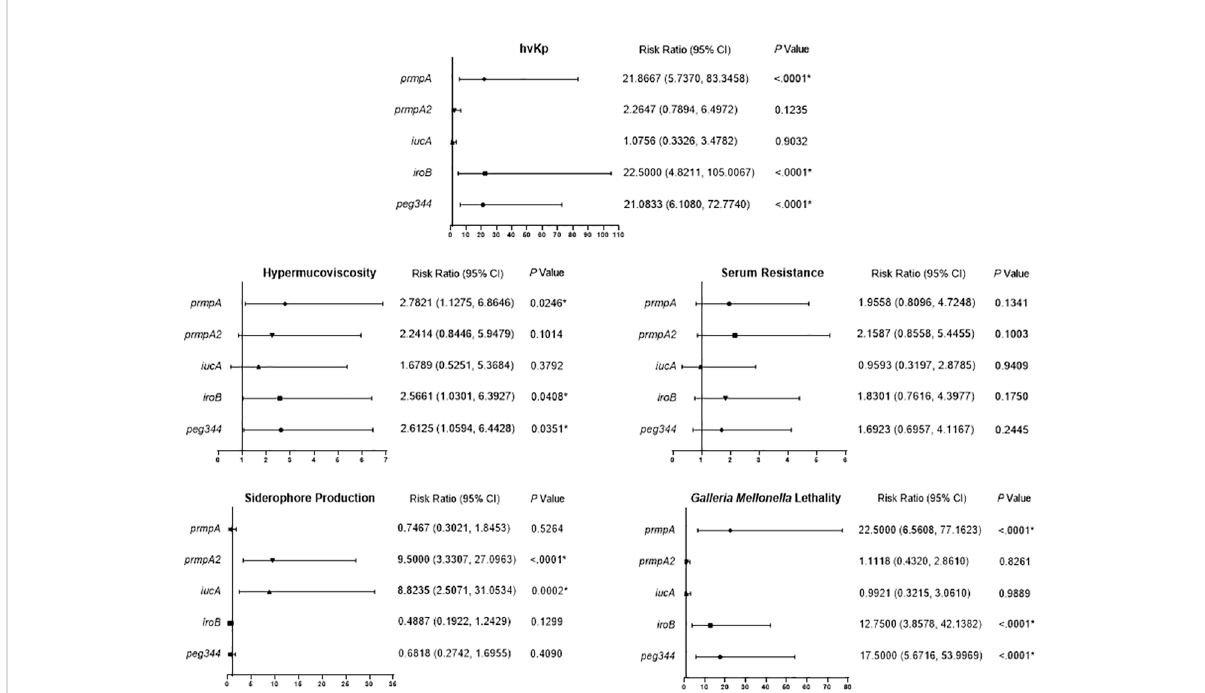
FIGURE 4 Risk ratio of hypervirulence genes in virulence-associated phenotypes. Risk ratios (95% con fi dence interval [95% CI]) and P values are given for pertinent results. P < 0.05